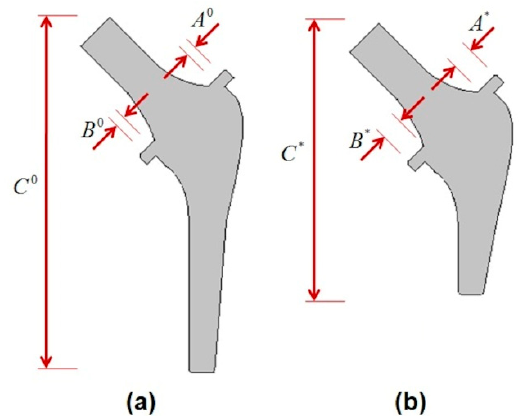
Figure 10. ( a ) Initial point and ( b ) optimal configuration. Table 6. Output parameters of the RBDO algorithm.